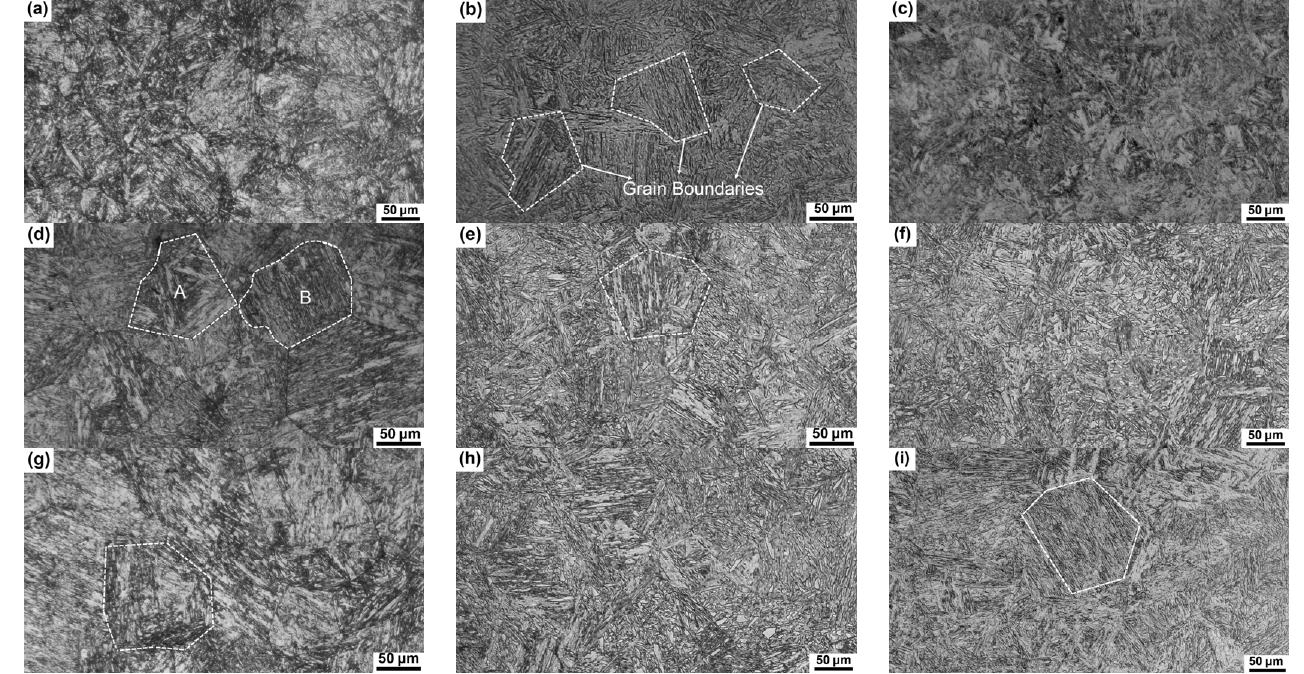
Figure 10. Metallographic microstructure at different peak temperatures and t 8/5 time: ( a ) 1200 °C, t 8/5 = 20 s, ( b ) 1200 °C, t 8/5 = 50 s, ( c ) 1200 °C, t 8/5 = 100 s, ( d ) 1250 °C, t 8/5 = 20 s, ( e ) 1250 °C, t 8/5 = 50 s, ( f ) 1250 °C, t 8/5 = 100 s, ( g ) 1300 °C, t 8/5 = 20 s, ( h ) 1300 °C, t 8/5 = 50 s, ( i ) 1300 °C, t 8/5 = 100 s.